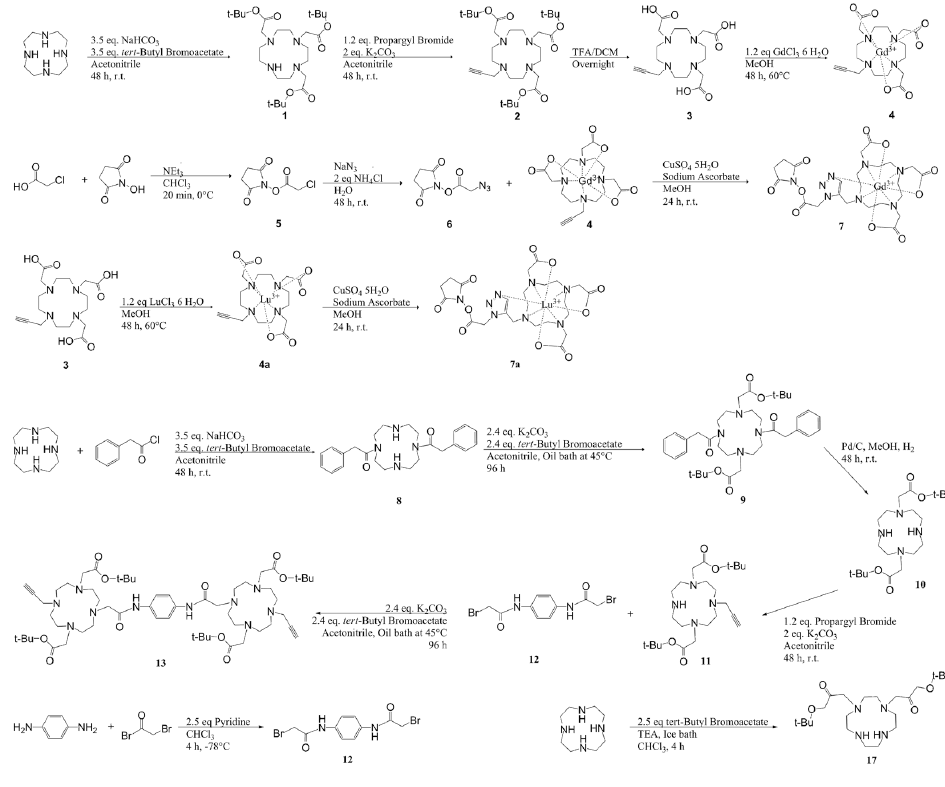
Figure 4. Synthetic pathway for molecules 1–13 and 17.